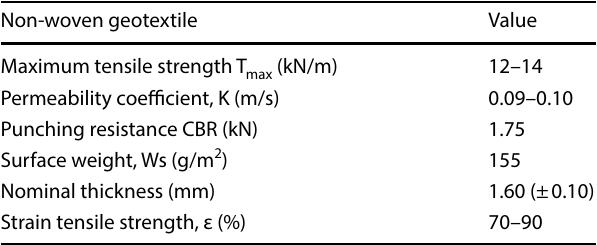
Table 2 Geotextile physical and mechanical characteristics Non-woven geotextile